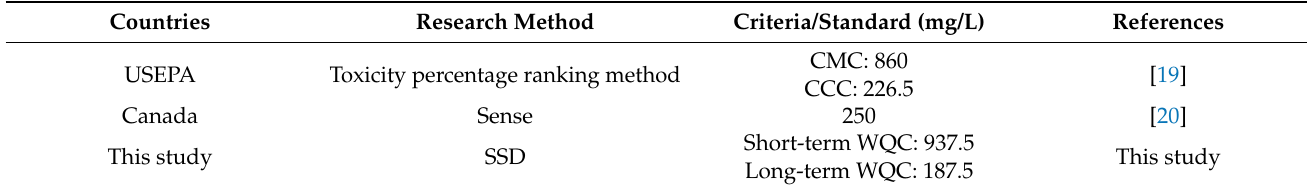
Table 5. Comparison of chloride water-quality criteria/standard